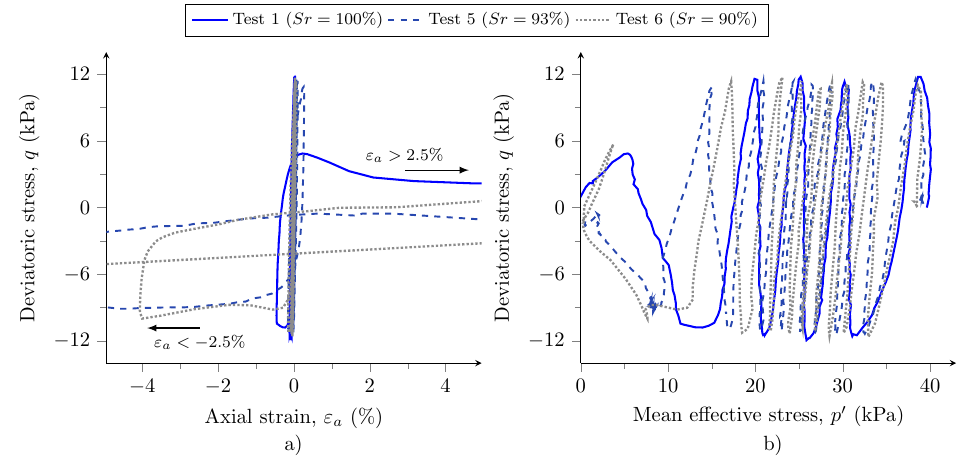
Figure 9. Comparison between cyclic triaxial tests under different Sr : ( a ) stress-strain behaviour; ( b )